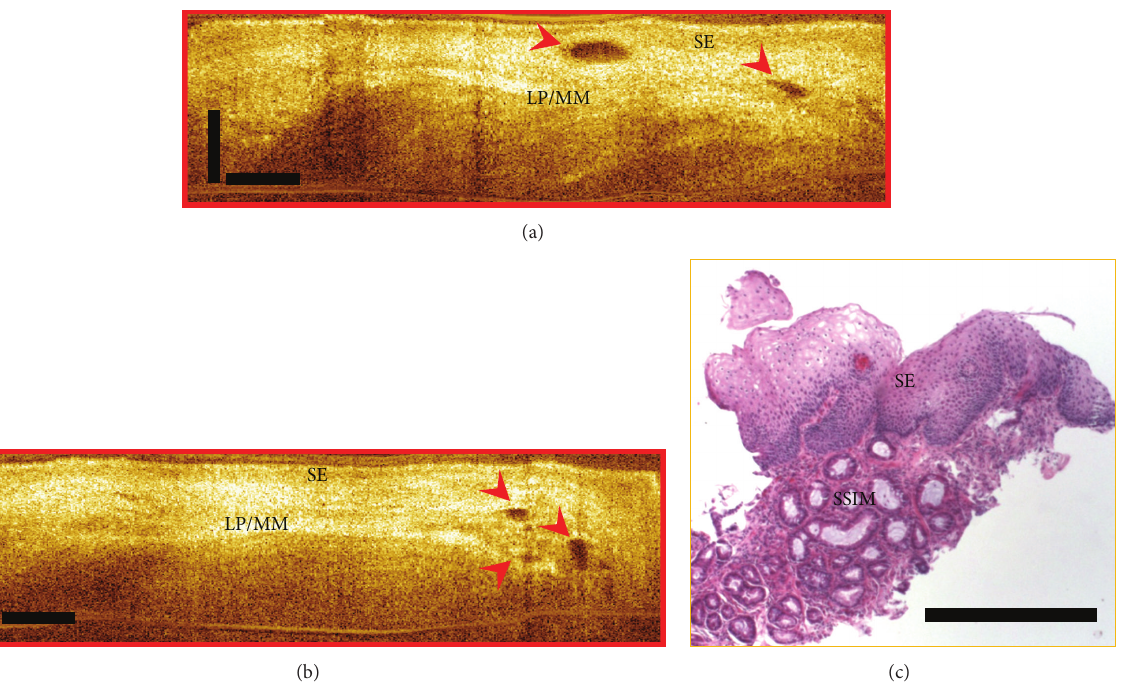
Figure 4: Subsquamous Intestinal Metaplasia (SSIM). (a-b): OCT images showing “buried glands” (red arrows). SE: squamous epithelium; LP/MM: lamina propria/muscularis mucosae. (c) Corresponding pathology showing subsquamous intestinal metaplasia under squamous